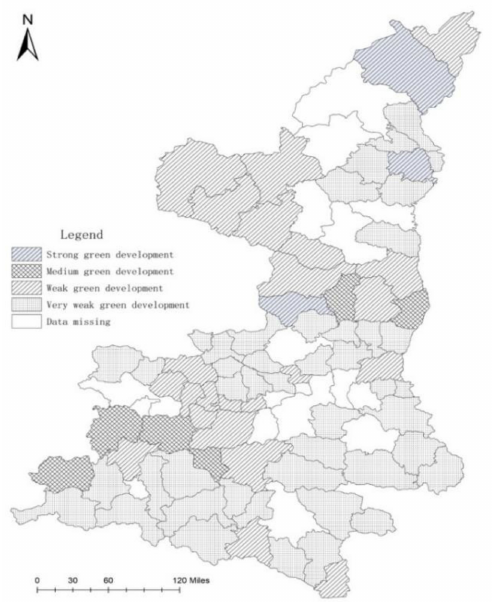
Figure 2. Rural green development degree of Shaanxi